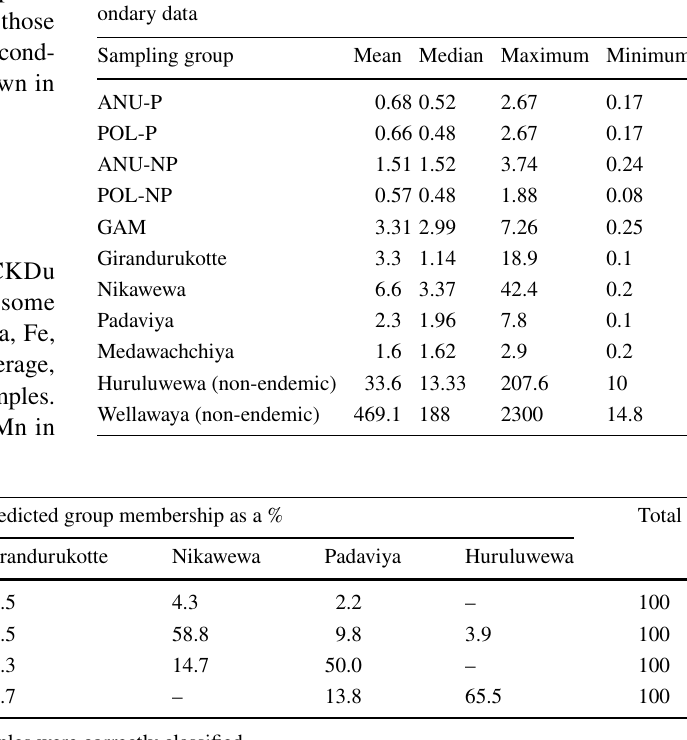
68.1% of the original samples were correctly